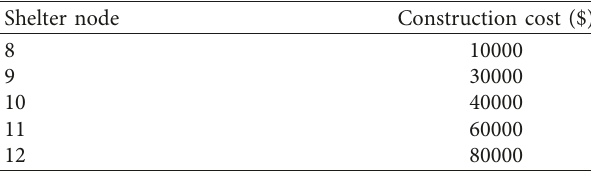
Table 6: Flow on links of network when minimising construction cost of shelters.